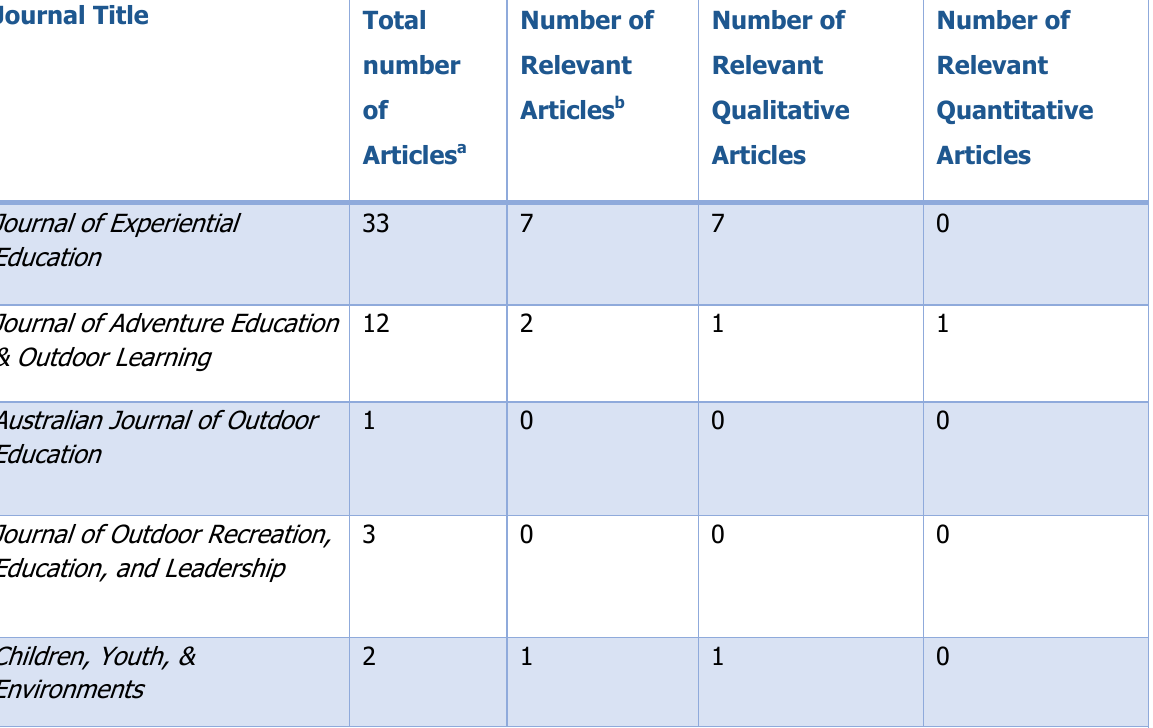
Table 1. Initial Literature Survey Assessing Current Peer-Reviewd Literature Related to Interpersonal Growth among Teachers and Students through Outdoor Education